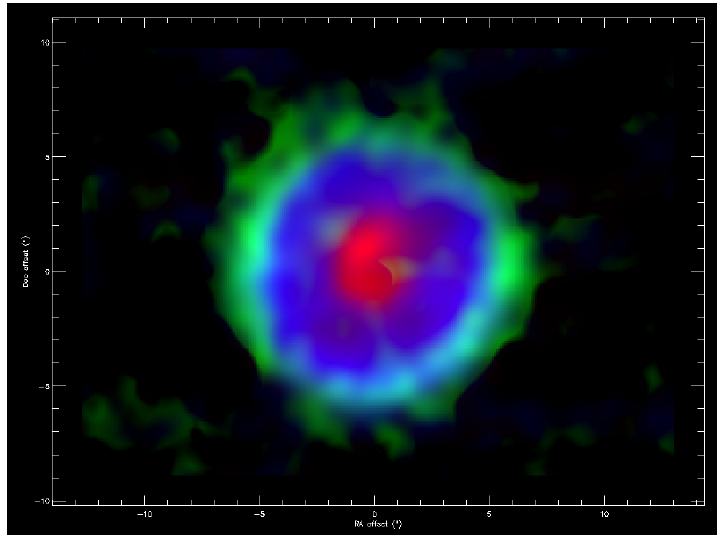
Figure 2. Decomposition of Gemini/T-ReCS narrow-band infrared images of Tc 1 into the different components (Cami et al., in prep): the continuum dust emission (red), the ionized gas (blue), and the fullerene emission